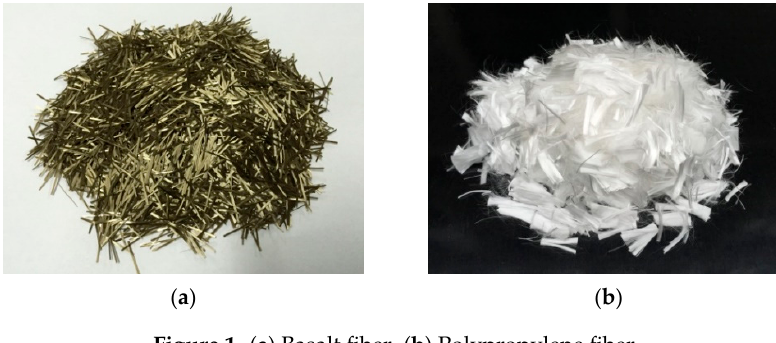
Figure 1. ( a ) Basalt fiber. ( b ) Polypropylene fiber. Table 1. Chemical composition and physical properties of cementitious materials.